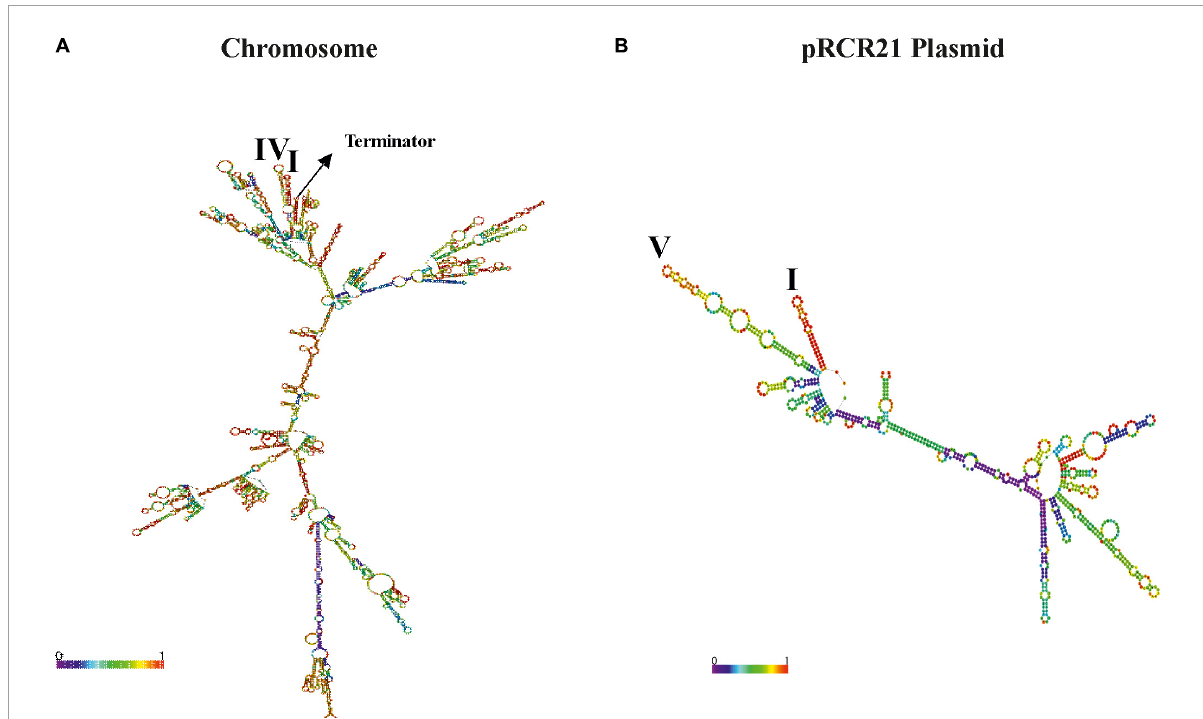
FIGURE5 Predicted folding of the transcripts driven from P dsrLL promoter in Lc. lactis AV1n[pRCR21]. (A) The chromosomal drLL mRNA is depicted, along with the location of complex secondary structures I and IV as well as the Rho-independent terminator. (B) The mrfp transcript encoded by pRCR21 is depicted, along with the location of complex secondary structures I and